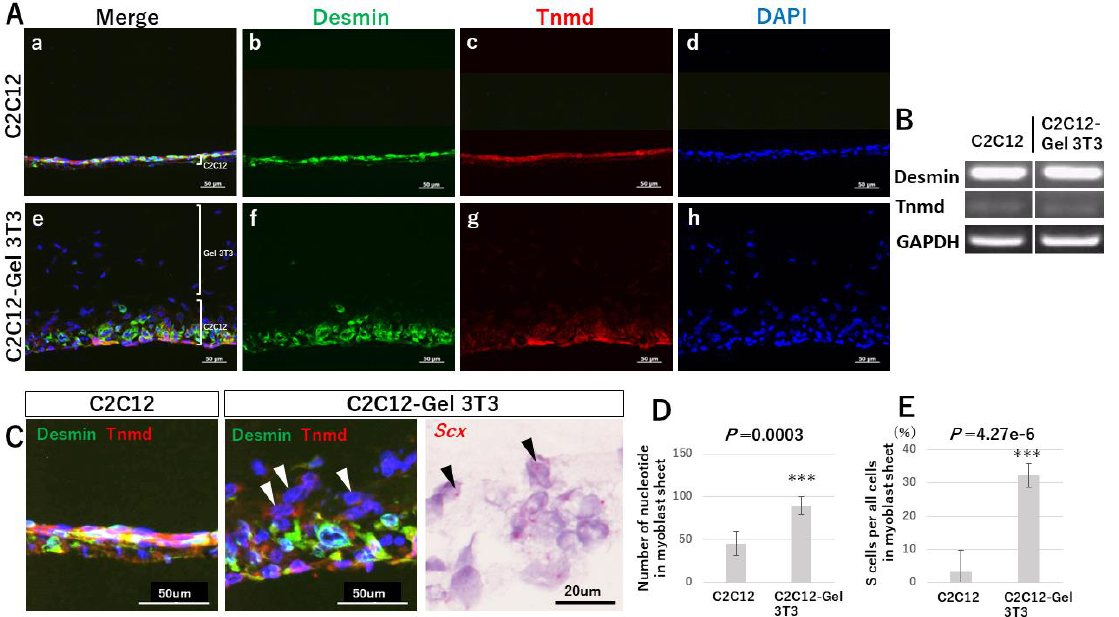
Figure 4. Morphology of myoblast sheets of C2C12-Gel 3T3, in comparison with C2C12 after 1 week of culture. ( Panels A , D ) The total cell count in the myoblast sheets was greater in C2C12-Gel 3T3 than in C2C12 (C2C12: 45.67 ± 14.30, C2C12-Gel 3T3: 89.83 ± 10.79, n = 6). Desmin and Tnmd were expressed. No difference in desmin and Tnmd expression was evident between C2C12 and C2C12-Gel 3T3 (Panel A b , c , f , g ). ( Panel B ) mRNAs for desmin and Tnmd were expressed in the cell sheets. ( Panels C , E ) The boundary between C2C12 and the gel in C2C12-Gel 3T3. Desmin was not expressed, but superficial cells expressing Tnmd (S cells, arrowheads) were evident. However, few S cells were identified in C2C12 (C2C12: 3.50 ± 6.21%, C2C12-Gel 3T3: 32.27 ± 3.59%, n = 6). The S cells expressed Scx. *** p < 0.001.